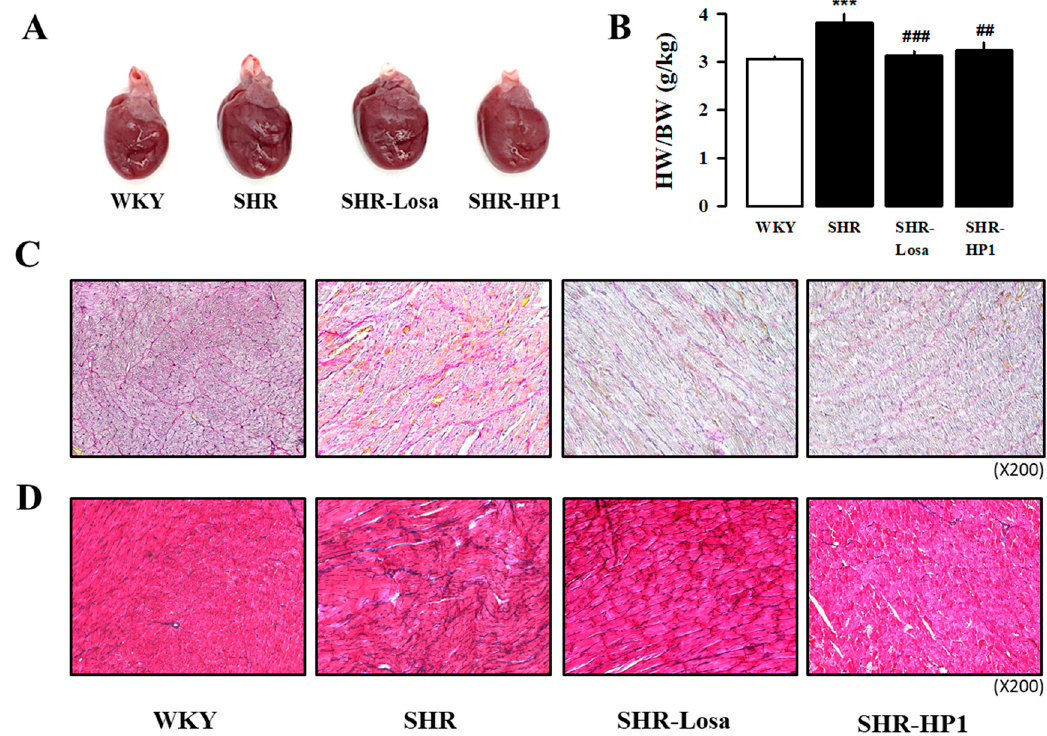
Figure 4. Effect of HP1 on cardiac hypertrophy and fibrosis. The HP1 treatment attenuated ventricular remodeling in SHR. The appearance of the whole hearts from each group ( A ). The numerical data to calculate the heart weight/body weight (HW/BW) ratio are shown ( B , n = 10~12 for each group). The detailed anatomy of the changes in picrosirius red staining ( C , upper panels) and Masson’s trichrome staining ( D , n = 3 for each group) of ventricular tissue from each group. WKY, Wistar-Kyoto rat; SHR, spontaneously hypertensive rat; Losa, losartan; and HP1, Vitis labrusca leaves extract. Open bar, WKY; closed bar, SHRs. Data are shown as means ± standard error. *** p < 0.001, compared with the WKY group; ## p < 0.01, and ### p < 0.001 compared with the SHR group.